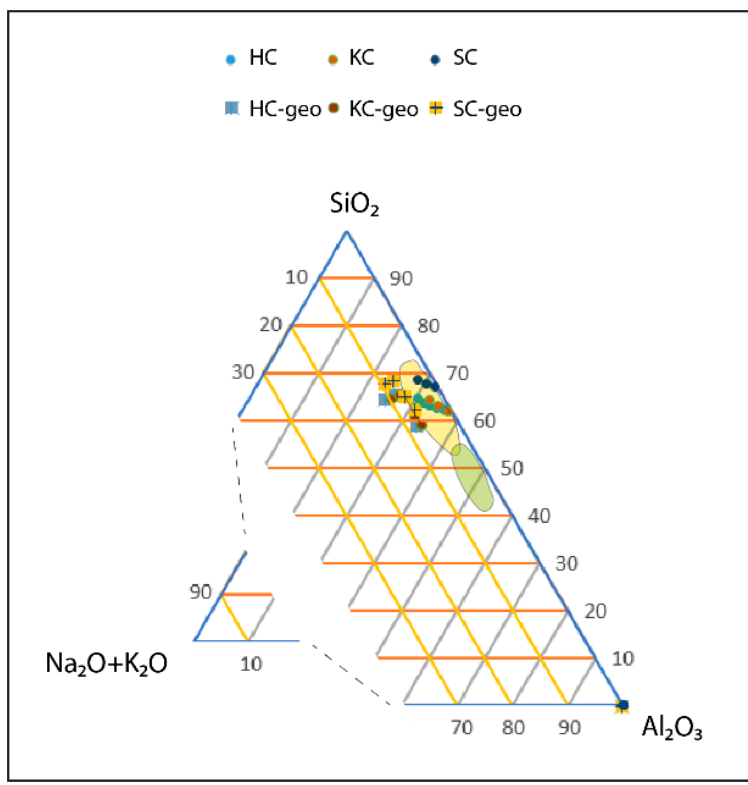
Figure 1. Ternary diagram reporting the as received raw materials and their corresponding geopolymers with respect the two separate areas of typical 2:1 clay minerals (yellow area, richer in SiO 2 ) and 1:1 clay mineral (green area, richer in Al 2 O 3 ). Data for the two phyllosilicate areas have been elaborated from [1].